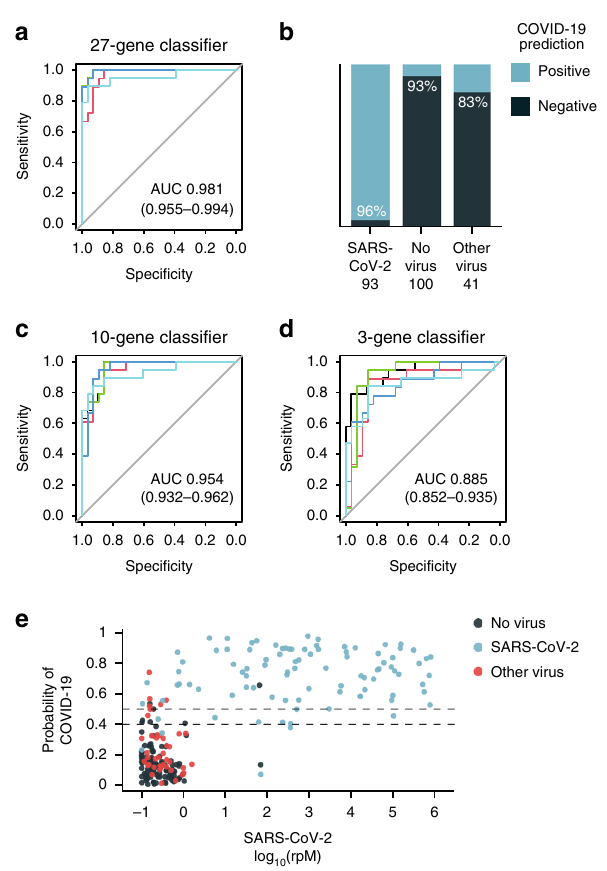
Fig. 2 Performance of COVID-19 diagnostic classi fi ers based on patient gene expression. a Receiver operating characteristic (ROC) curve for a 27- gene classi fi er that differentiates COVID-19 from other acute respiratory illnesses (viral and non-viral). The mean and range of the area under the curve (AUC) are indicated. b Accuracy of the 27-gene classi fi er within each patient group using a cut-off of 40% out-of-fold predicted probability for COVID-19. c ROC curve for a 10-gene classi fi er. d ROC curve for a 3-gene classi fi er. e Out-of-fold predicted probability of COVID-19 derived from the 27-gene classi fi er plotted as a function of SARS-CoV-2 viral load, log 10 (rpM). Dashed lines indicate 40% (our chosen cut-off) and